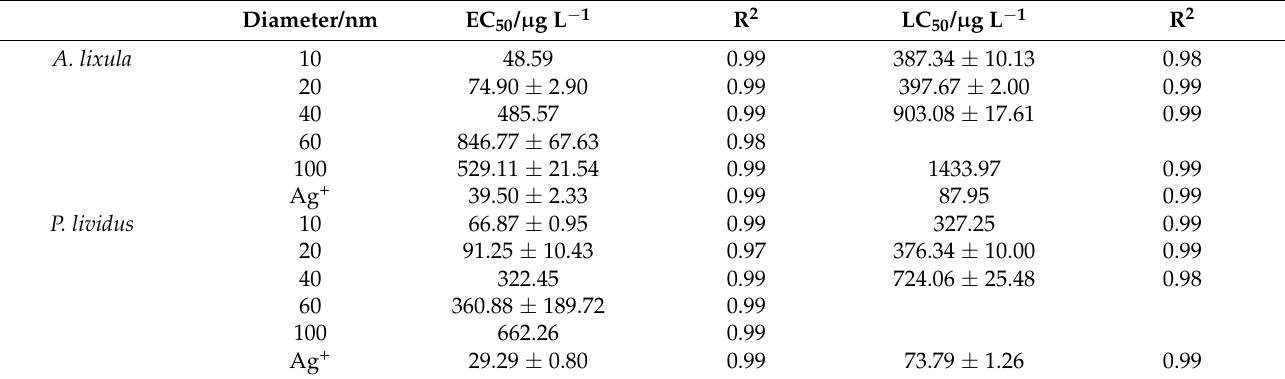
Table 1. Calculated EC 50 and LC 50 values ( ± SE) for A. lixula and P. lividus plutei exposed to AgNPs of different sizes for 48